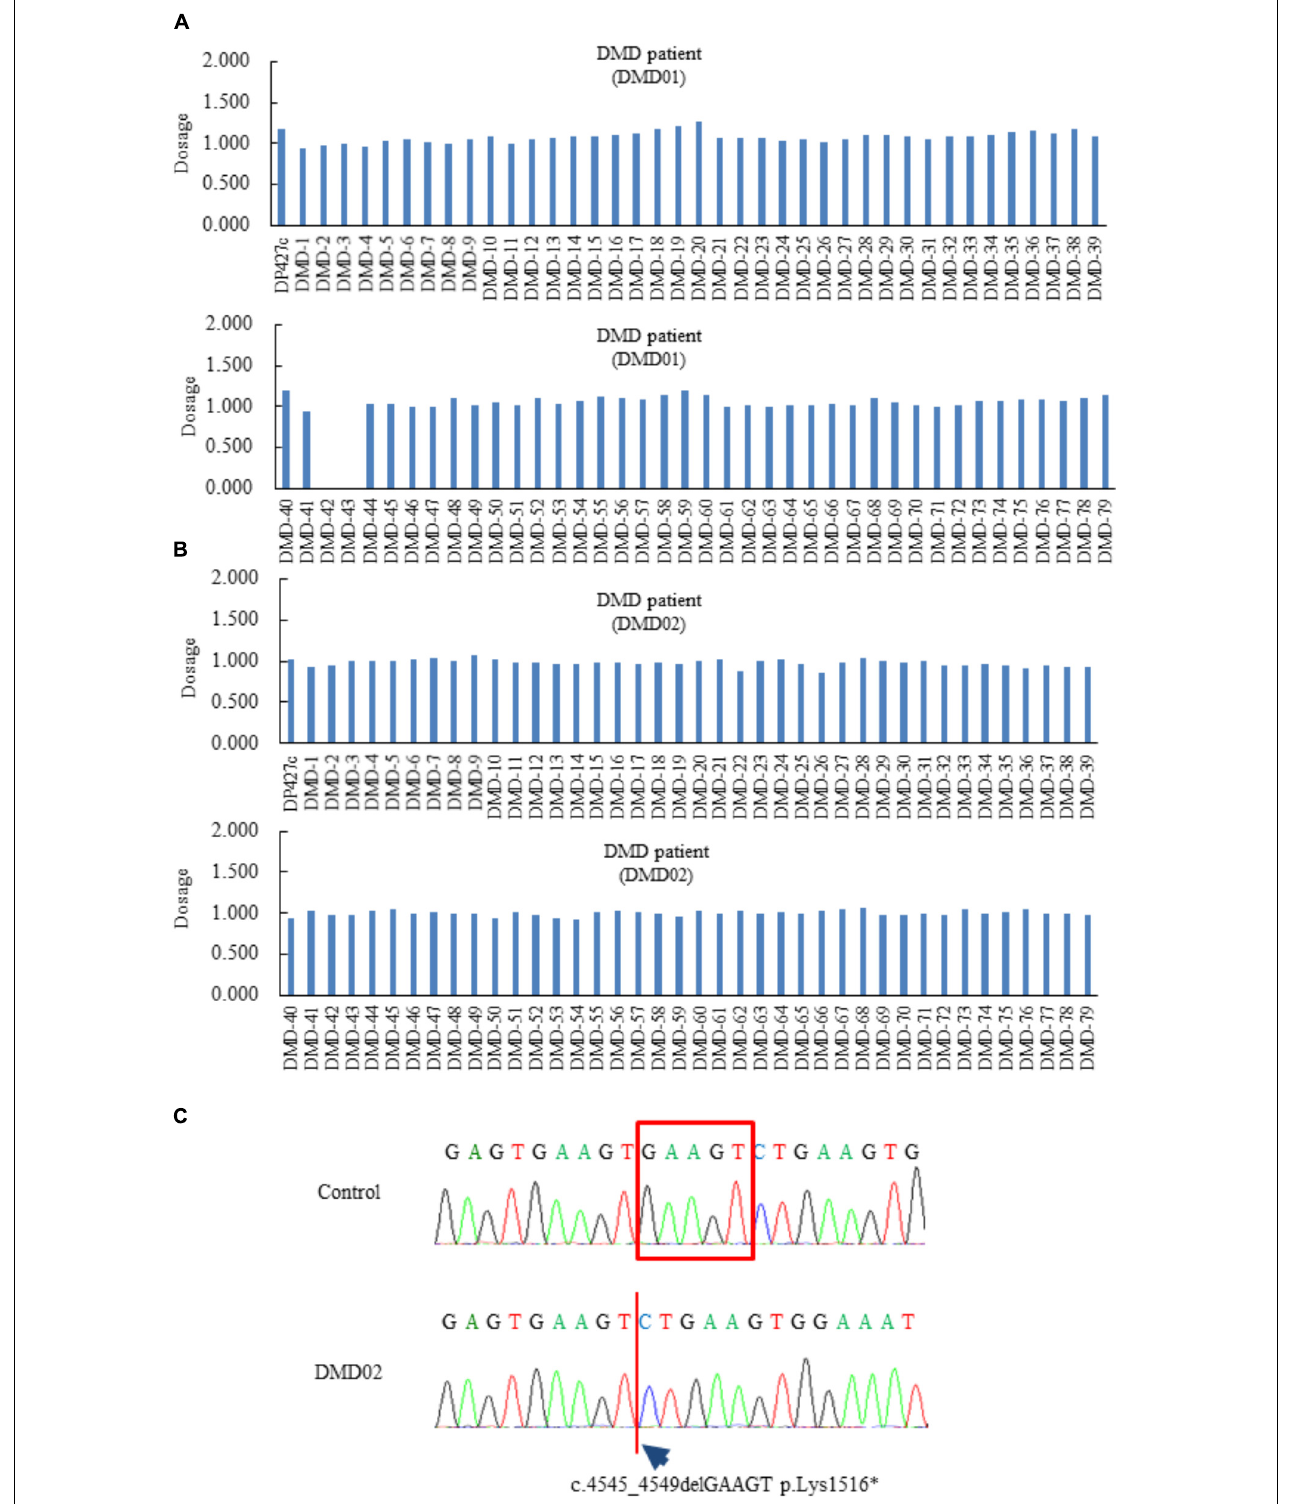
FIGURE 1 | Genetic diagnosis of Duchenne muscular dystrophy (DMD) patients (DMD01 and 02) used in this study. (A–C) The Multiplex ligation-dependent probe amplification analysis of the DMD patients (DMD01 and 02) in this study. The exons 42 and 43 deletion were found in DMD01, but no deletion and duplication in DMD02. DMD02 showed c.4545_4549delGAAGT, p.Lys1516 ∗ in exon 33.